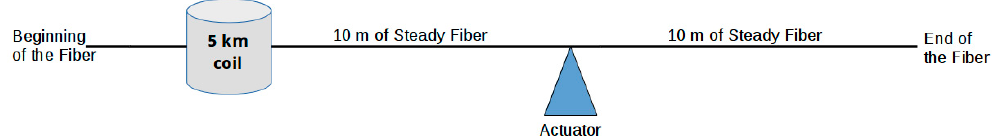
Figure 9. Test setup to determine the spatial resolution of the system at the end of the fiber (less sensitive zone). A harmonic tone is applied in the middle of the lead 20-m fiber by an audio actuator, while the rest of the fiber is kept steady.